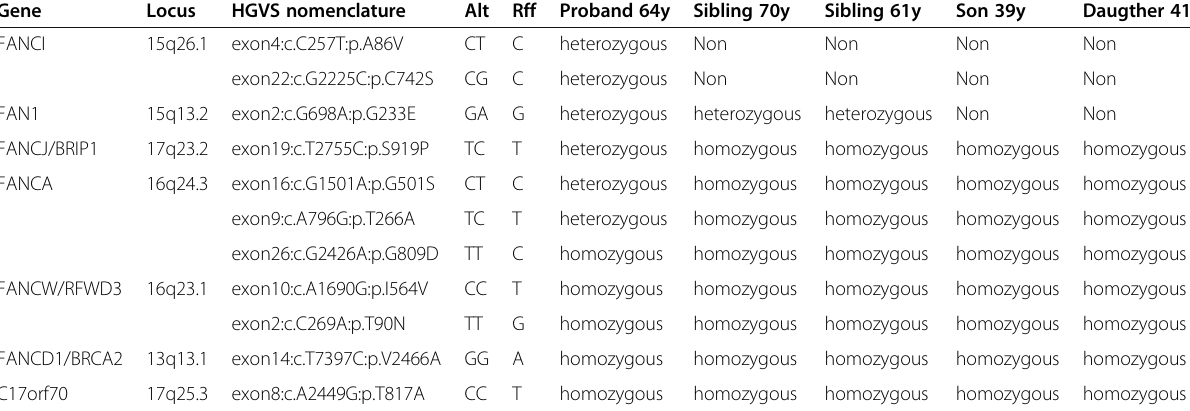
Table 2 The sanger suquencing of germline variants in proband and family members Gene